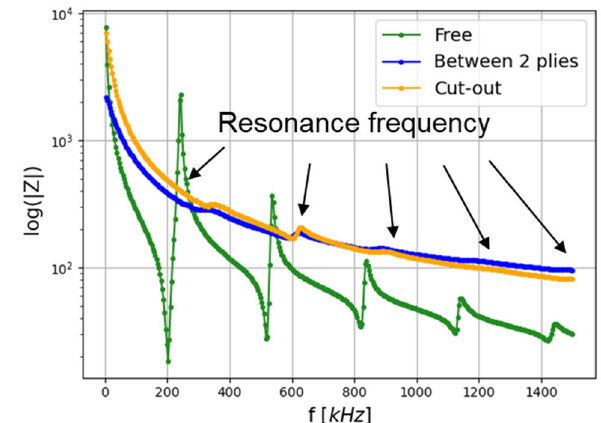
Figure 7. The impedance of the free PZT (green) and the embedded PZT with electrical insulation with the two methods of integration (blue: between two plies and orange: cut-out).